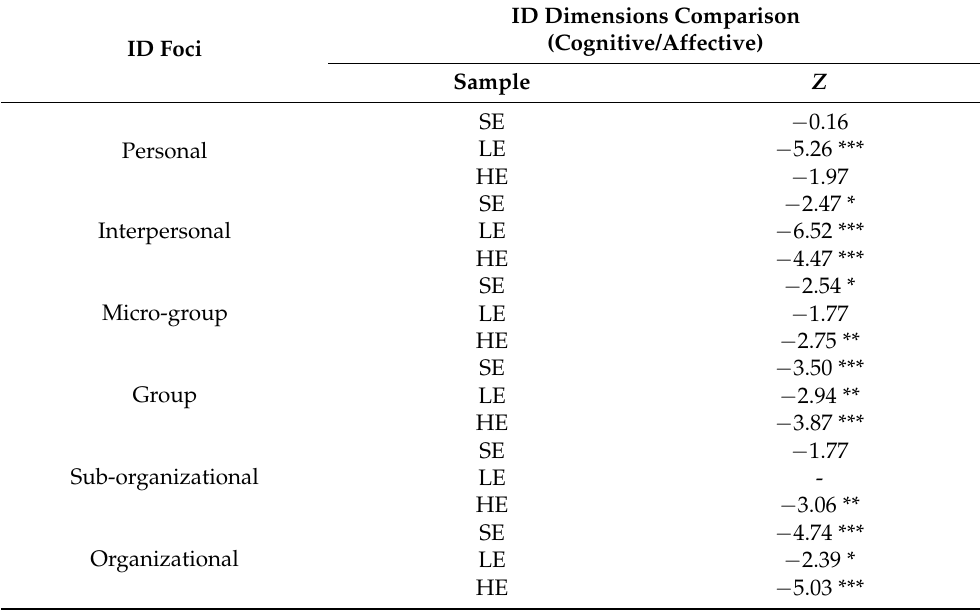
Table 3. Comparison of Cognitive and Affective Dimensions for Each ID